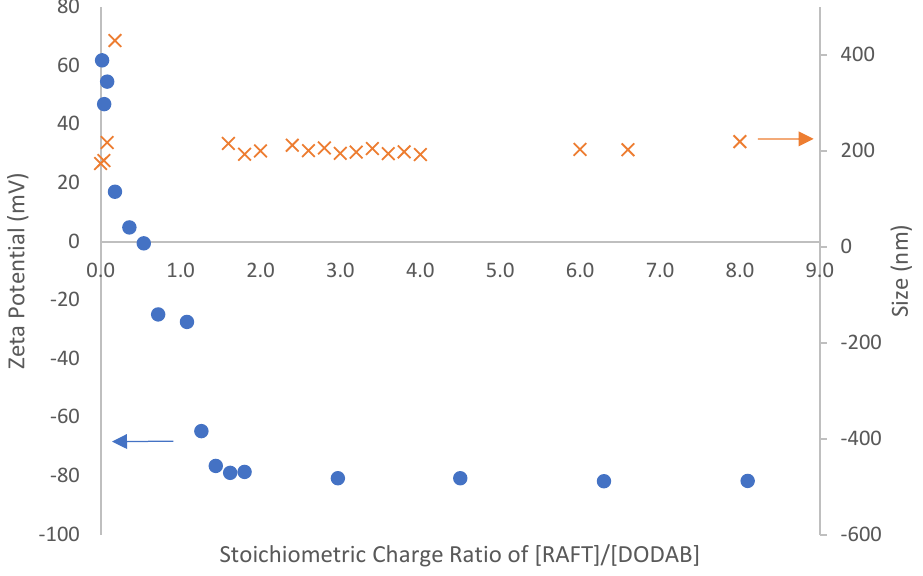
Figure 8. Adsorption of Oligo 2A [BM1361 (BA 6 - co -AA 9 )] to DODAB vesicle as a function of stoichiometric charge ratio parameter.